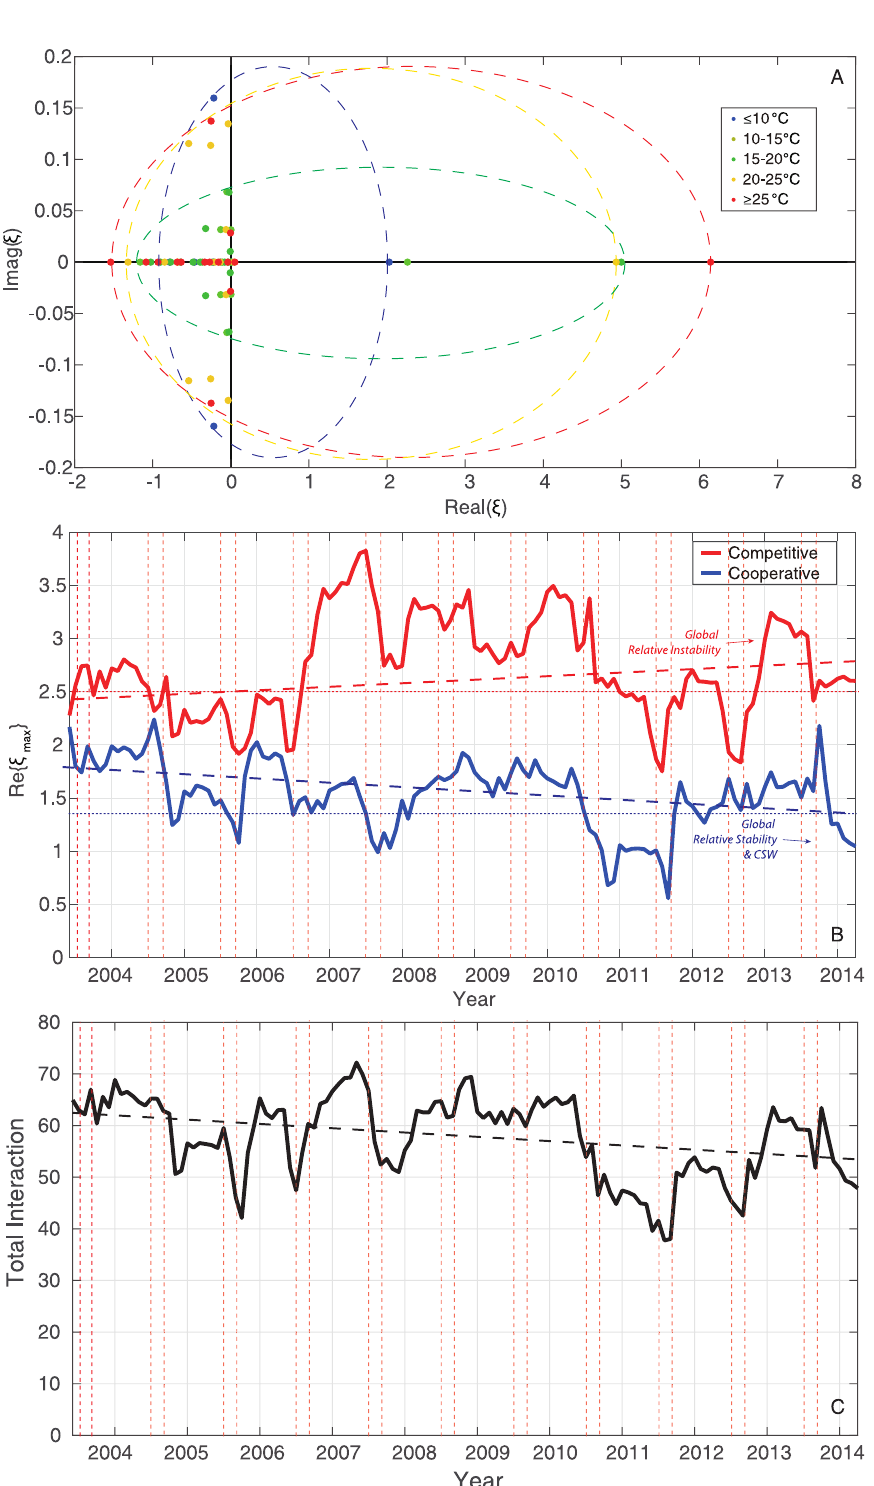
Fig 6. Eigenvalue spectrum of TE interaction matrices across temperature ranges and ecosystem relative stability over time. Eigenvalue distribution of TE interaction matrices are scattered in a complex plane (five different colors correspond to five TRs) ( A ). Dynamical stability of the fish community is computed as the real part of the dominant eigenvalue of TE interaction matrices; this is show over time ( B ) for competitive (4–9 species) and cooperative species. The total interaction of dynamical networks over time (as sum of all TE interactions) ( C ) is mirroring the fluctuations